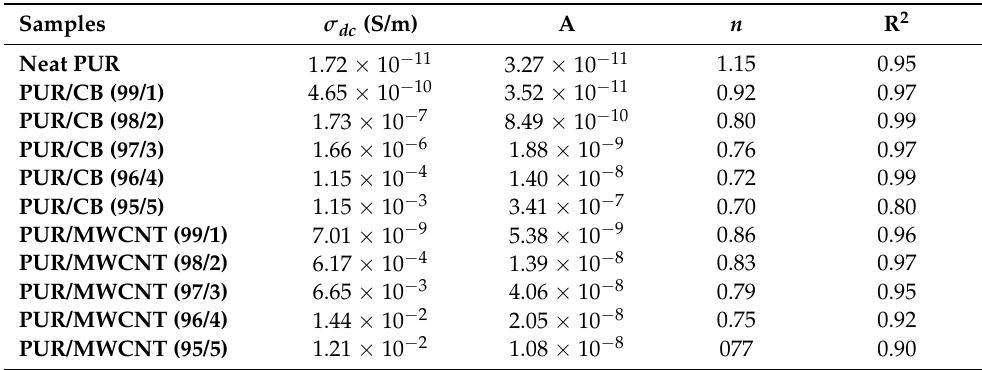
Table 2. Parameters obtained from fitting of the experimental data using the Jonscher’s equation for PUR/MWCNT and PUR/CB nanocomposite samples and neat